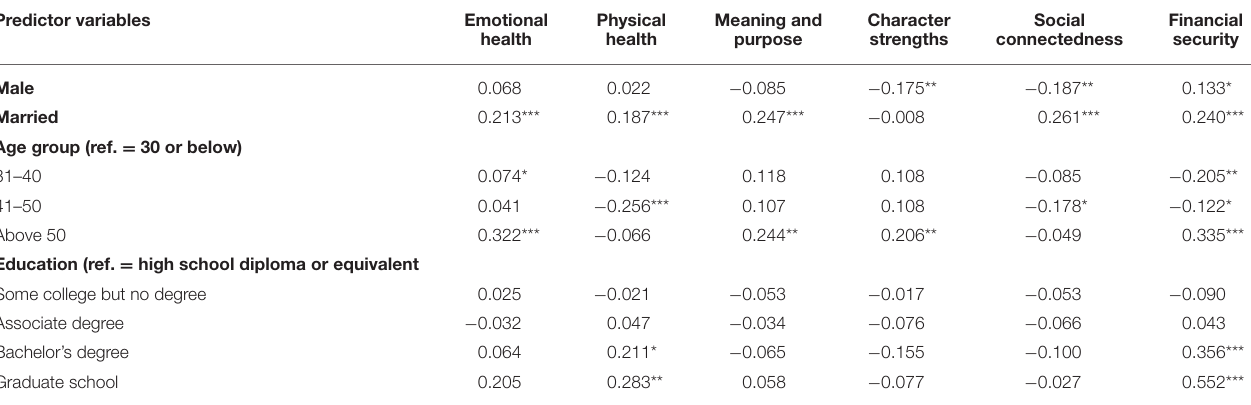
TABLE 8 | Association between six WBA factors and demographic variables. Predictor